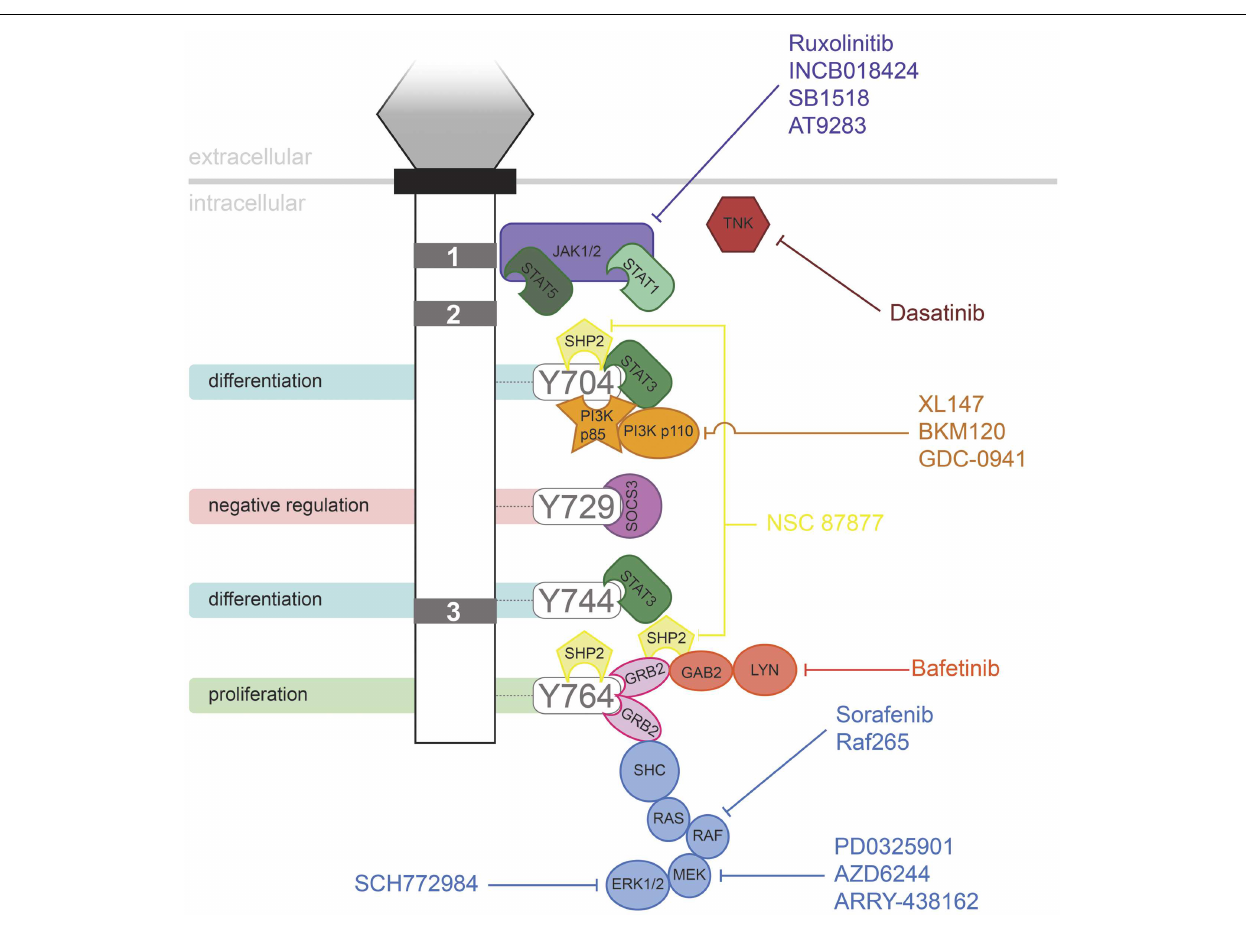
as well as the tyrosine residues that serve important docking sites for the downstream signaling proteins indicated. Known inhibitors of these are